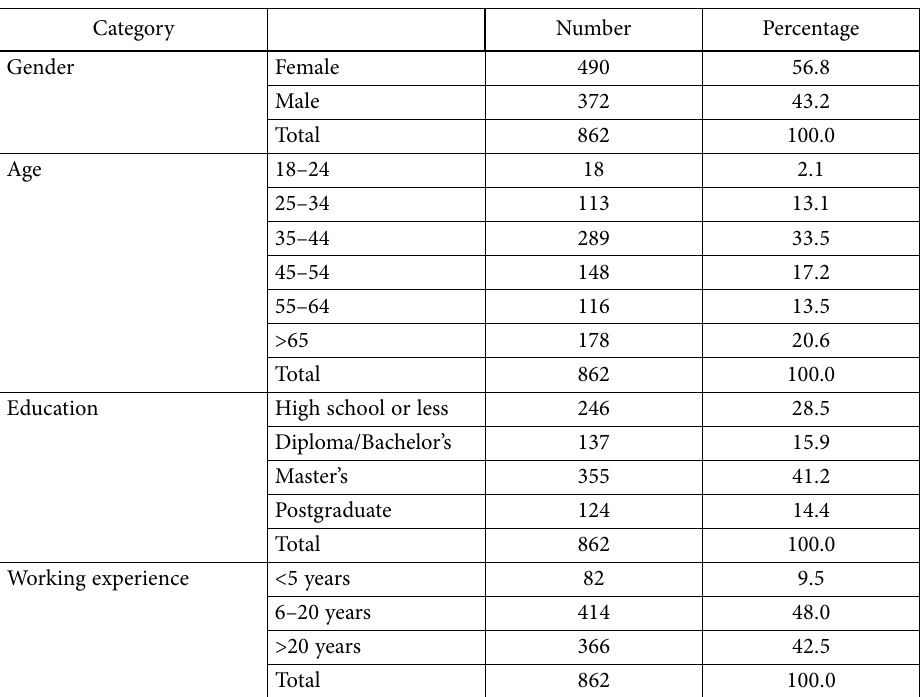
Table 2. Respondent’s profile